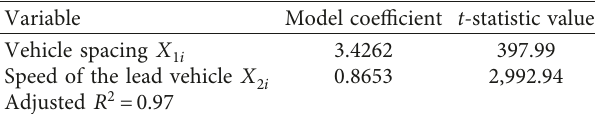
Table 4: Calibrated coefficients of the proposed CFS